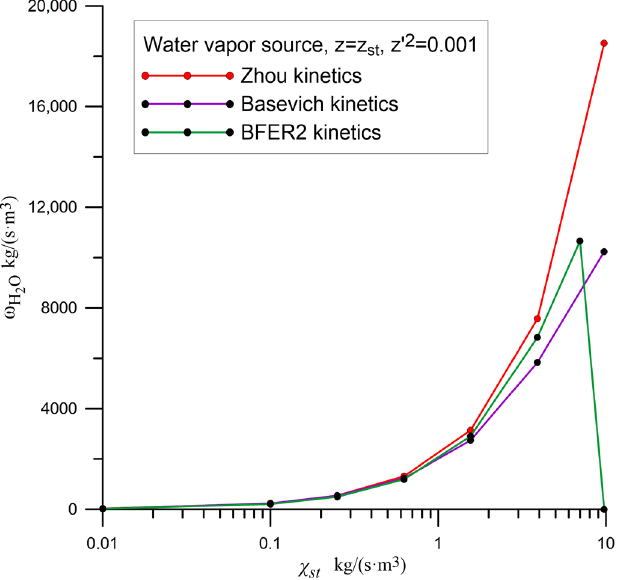
Figure 1. Averaged water vapor source comparison. Purple line denotes Basevich et al. kinetics, red line denotes Zhou kinetics, green line denotes Franzelli et al. BFER2 kinetics.